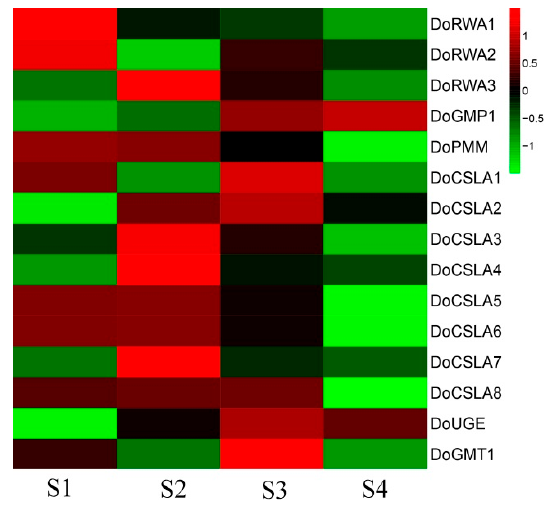
Figure 7. Expression profiles of three DoRWA genes and other polysaccharide-related genes in four developmental stages. RPKM values of different genes were log-transformed (log of mean RPKM).